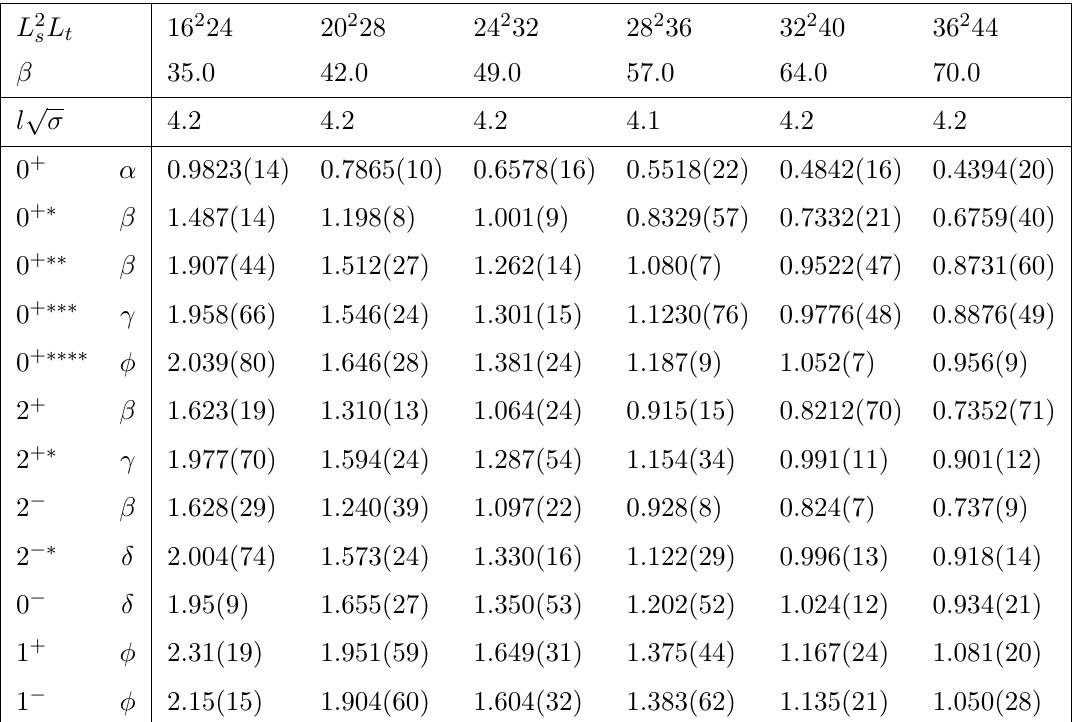
Table 24 . SO(7) glueball masses am G . Grades, e.g. (cid:11) , explained in section 3.6.6.